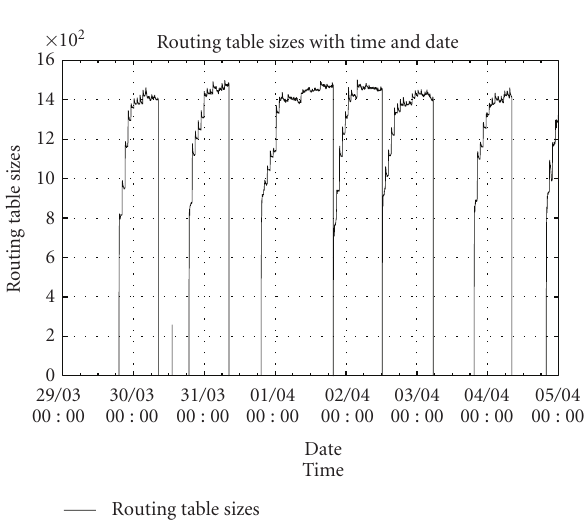
Figure 2: Routing table size.